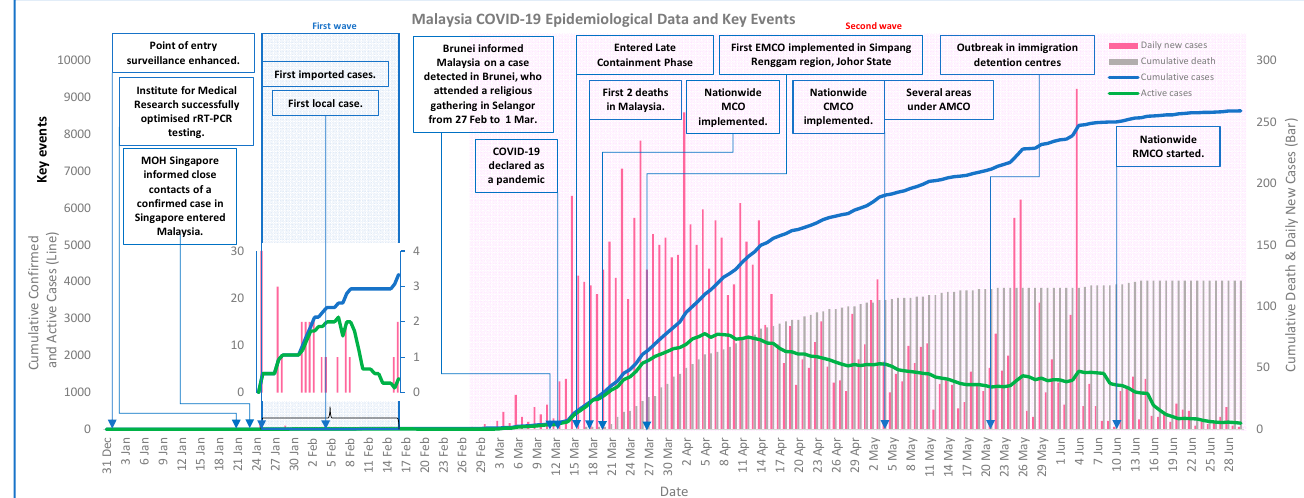
Figure 2. Key events and reported COVID-19 cases in Malaysia.